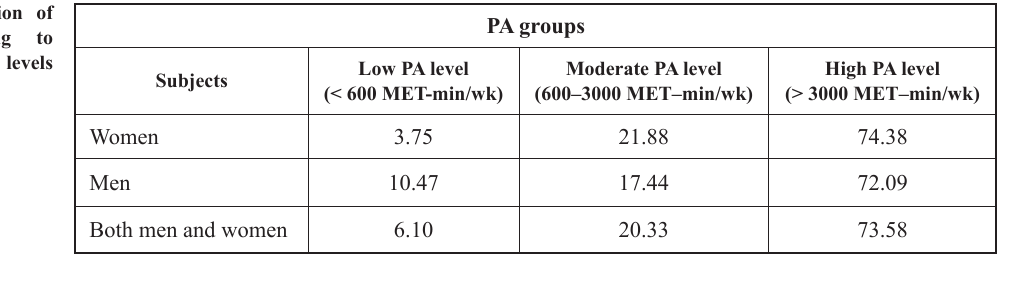
Table 2. Distribution of mean calories expended per week for different